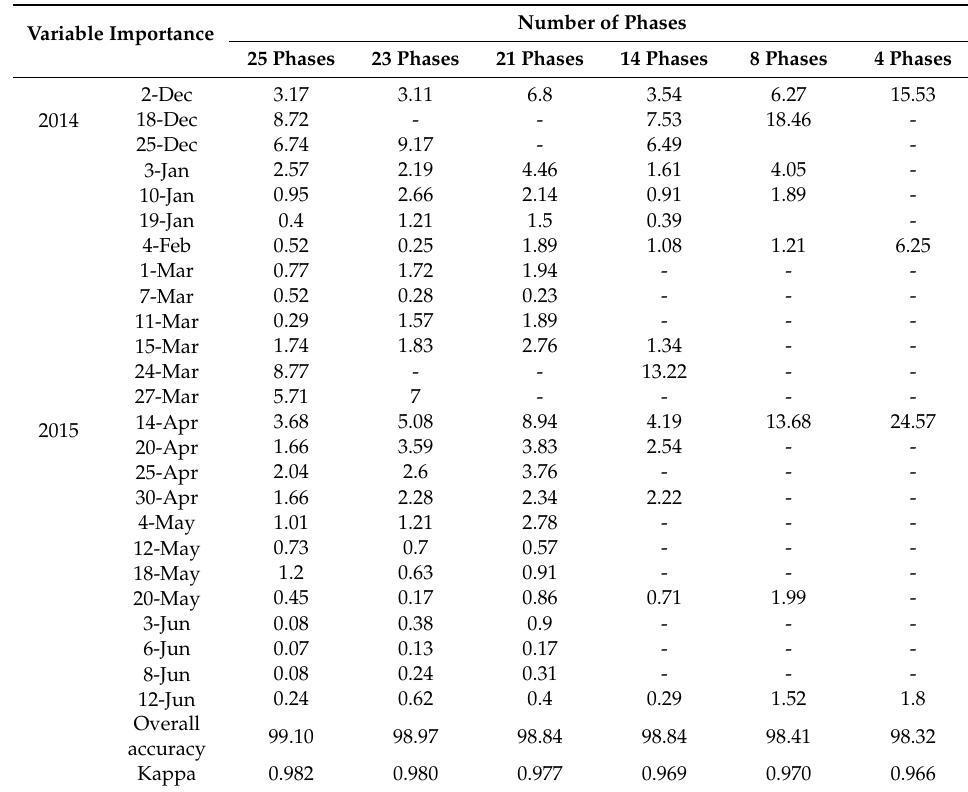
Table 8. Determination of the date range of important